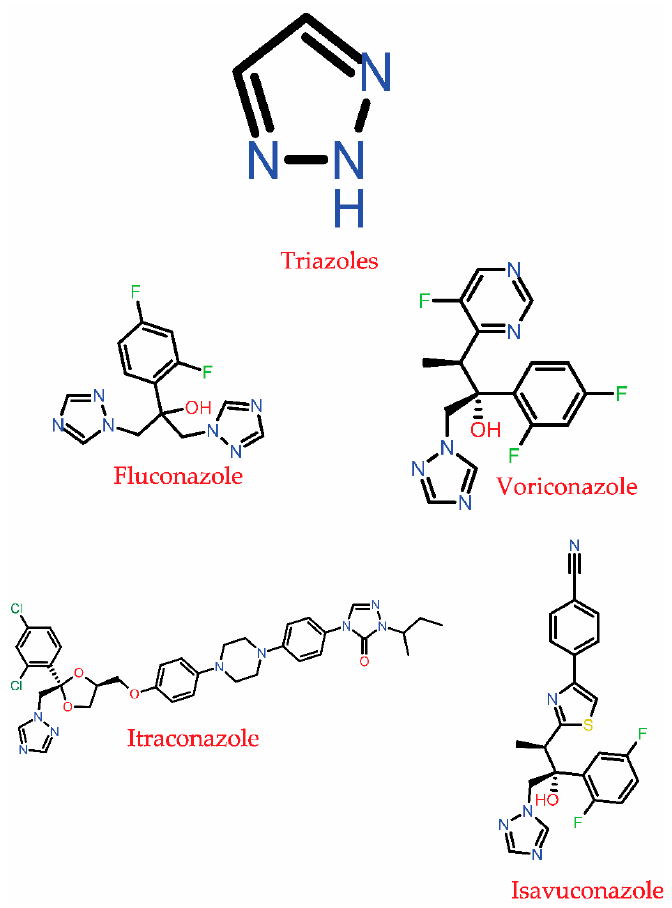
Figure 6. Two-dimensional structure of drugs under triazole group.